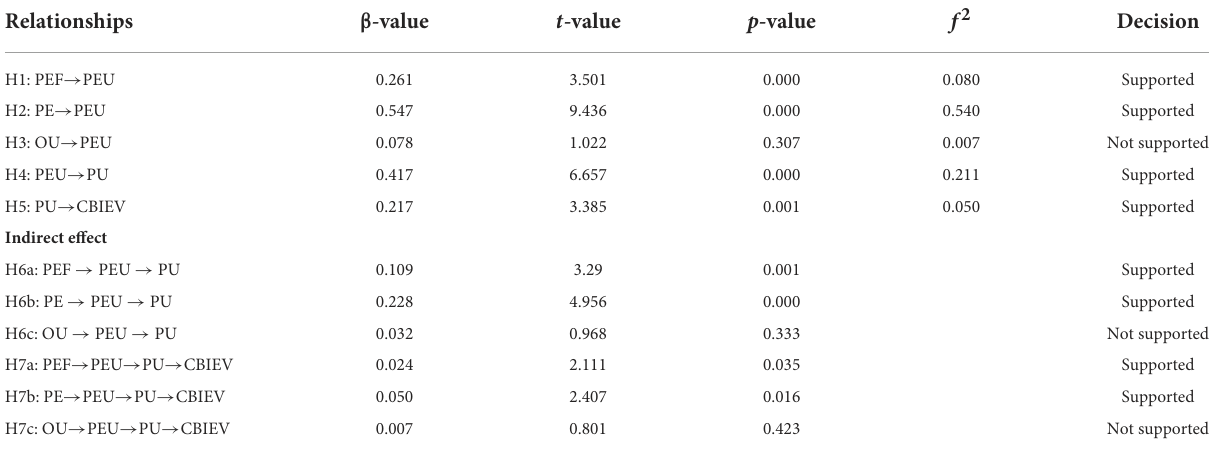
TABLE 6 Structural model and effect